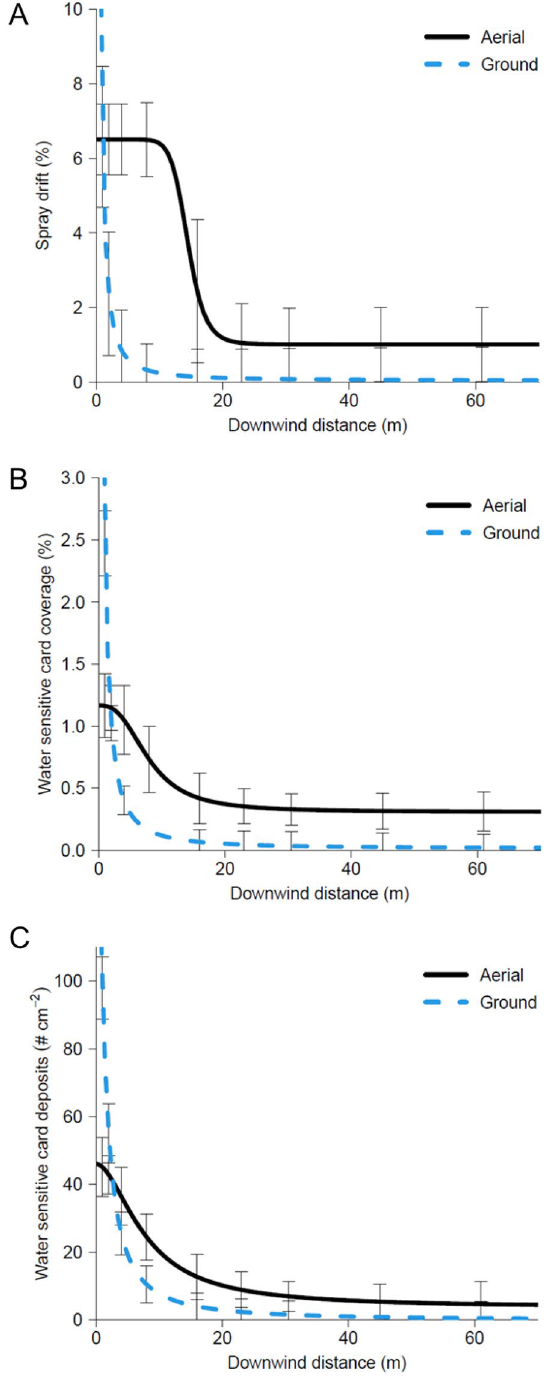
Figure 2. Mylar card spray drift deposition ( A ), water sensitive card coverage ( B ), and water sensitive card number of deposits ( C ) modeled using four parameter log-logistic regressions to evaluate measured spray drift from ground and aerial application